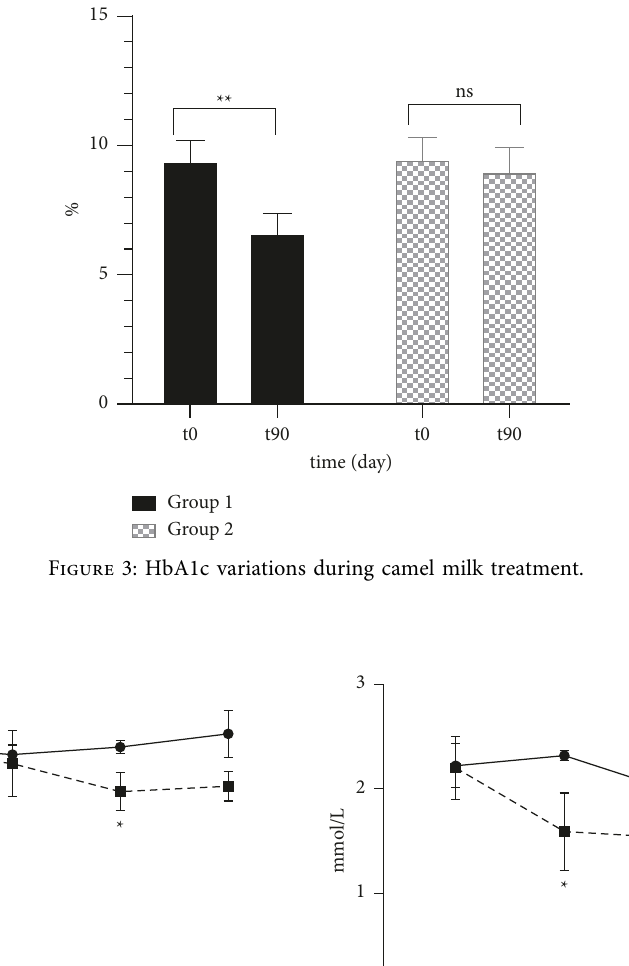
Significant difference compared to ∗